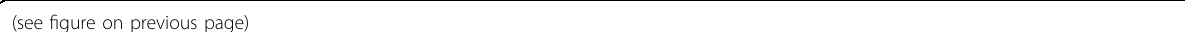
Fig. 2 Ef fi cacy and toxicity of apatinib in sarcoma patients. a Overall responses of 59 patients with stage IV sarcoma treated with apatinib. Among 59 patients, 51 had measurable lesions and eight patients had unmeasurable lesions. Responses were PR in nine (15.25%), SD in 25 (42.37%), and PD in 25 (42.37%). b , c PFS and OS in 59 patients treated with apatinib. b Median PFS was 7.93 months; PFR at 12 weeks was 74%. c Median OS was 17.27 months. d , e Frequency and prognostic role of apatinib toxicity in sarcoma patients. d Severe adverse events (AEs) included no grade 4 AEs and grade 3 AEs in nine patients (14.06%), mainly hypertension (HTN), hand-foot syndrome (HFS), proteinuria, fatigue, and dysgeusia. e : HTN, proteinuria, and HFS were signi fi cantly correlated with longer OS in this cohort, and patients who suffered from any of these three AEs during treatment had signi fi cantly longer OS than those without these